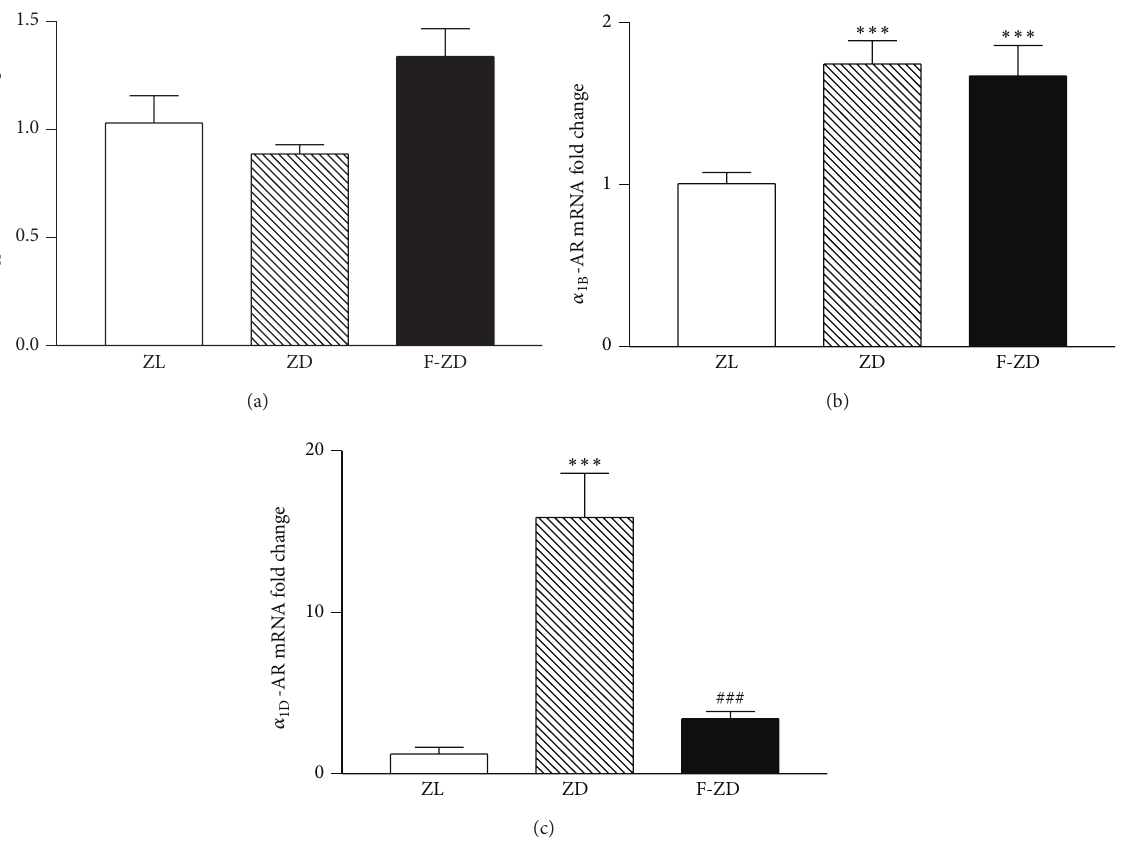
Figure 1: mRNA expression of renal cortical 𝛼 1 Zucker lean (ZL), vehicle-treated Zucker diabetic (ZD), and fenofibrate-treated Zucker diabetic (F-ZD) rats. Fold changes of 𝛼 1 - (c) AR genes were calculated using 𝛽 -actin as an internal control. Values are mean ± SEM. 𝑛 = 5 - 6 animals/group. ∗∗∗ 𝑃 < 0.001 (b), and 𝛼 1 D versus ZL; ### 𝑃 < 0.001 versus ZD